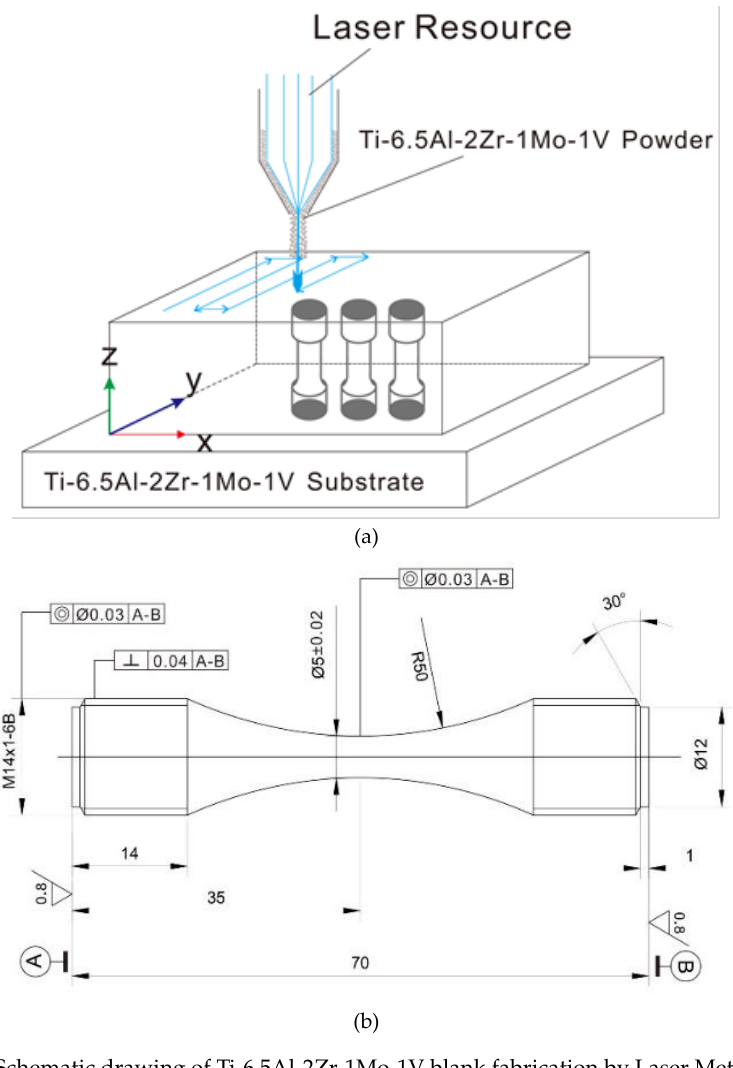
Figure 1. ( a ) Schematic drawing of Ti-6.5Al-2Zr-1Mo-1V blank fabrication by Laser Metal Deposition (LMD ) and cylindrical specimen extraction. ( b ) Schematic illustration of the specimen dimensions in mm [26].